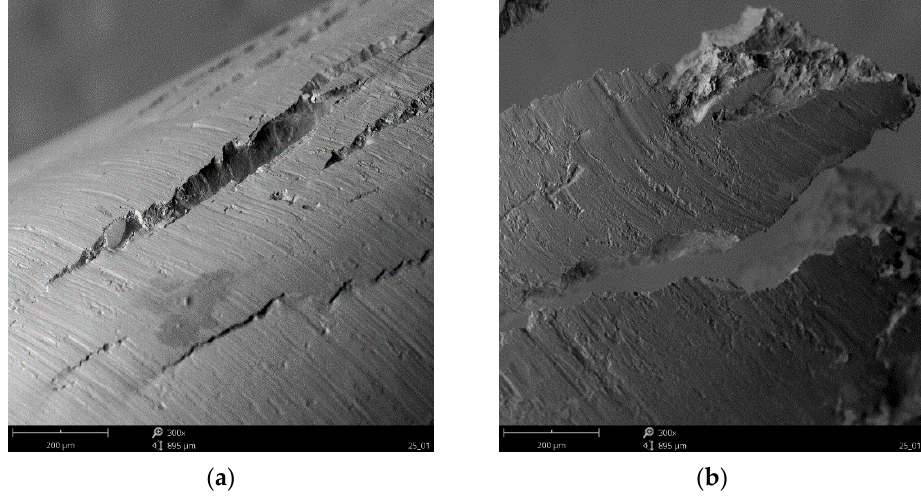
Figure 11. SEM imaging of a magnesium alloy chip surface on the free side ( a ) slip plane and ( b ) material decohesion.